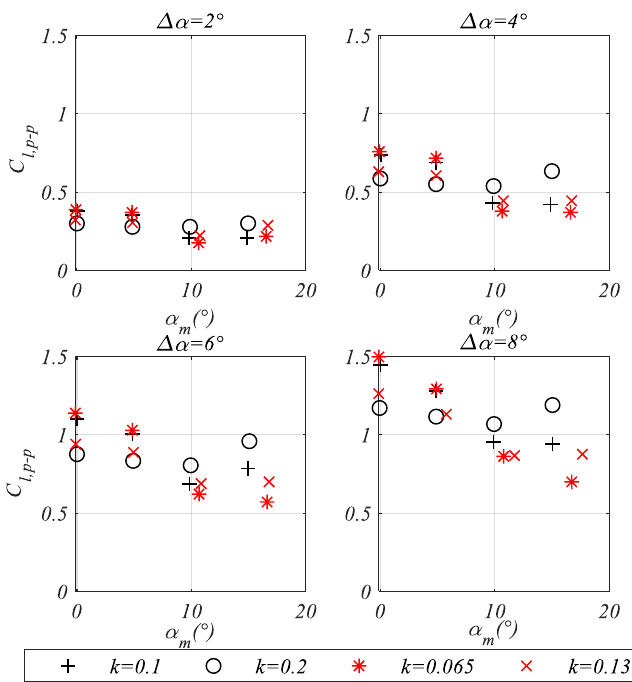
Figure 14. Peak-to-peak lift coefficient versus mean angle of attack, angle amplitude and reduced frequency.